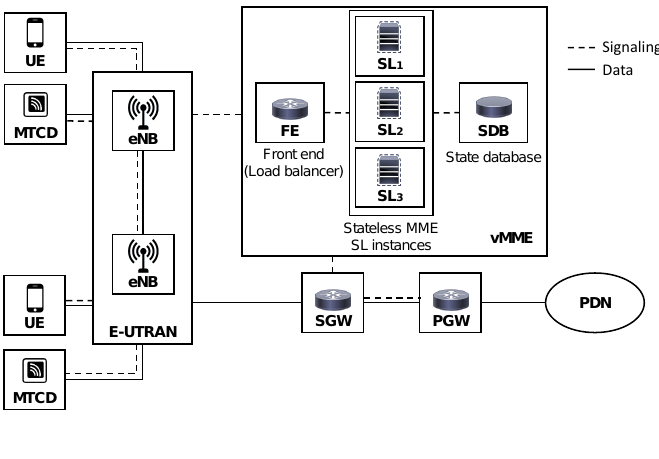
Figure 3. Overall system